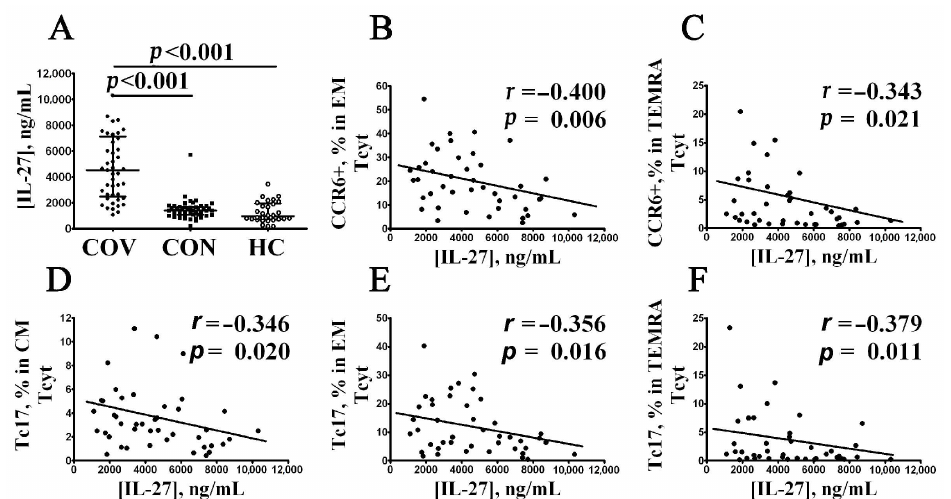
Figure 8. Correlation between elevated serum IL-27 level and CCR6+CD8+ T cells in acute COVID-19 patients. Comments: ( A ) IL-27 concentration (ng/mL) in patients with acute COVID-19 (black circles, COV, n = 45); convalescent COVID-19 individuals (black squares, CON, n = 48), and healthy control (white circles, HC, n = 30). Each dot represents individual subjects, and horizontal bars depict the group medians and quartile ranges (Med (Q25; Q75)). ( B – F ) Spearman correlation coefficient between serum IL-27 concentration and level of peripheral blood CCR6+ EM and CCR6+ TEMRA CD8+ T cells, as well as Tc17 CD8+ T cell subsets within CM, EM, and TEMRA CD8+ T cells, respectively.